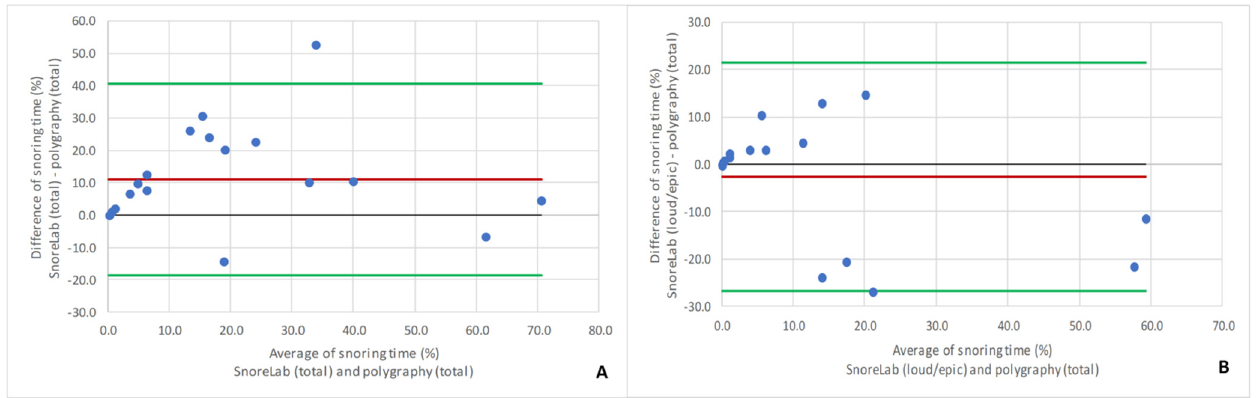
Figure 2. Bland–Altman plots for comparison of total snoring ratio measured by polygraphy with ( A ) total snoring ratio and ( B ) loud + epic snoring ratio measured by the SnoreLab app ( B ). Red line: mean difference of both methods; black line: optimal agreement between the methods; green lines: 95% limits of agreement.